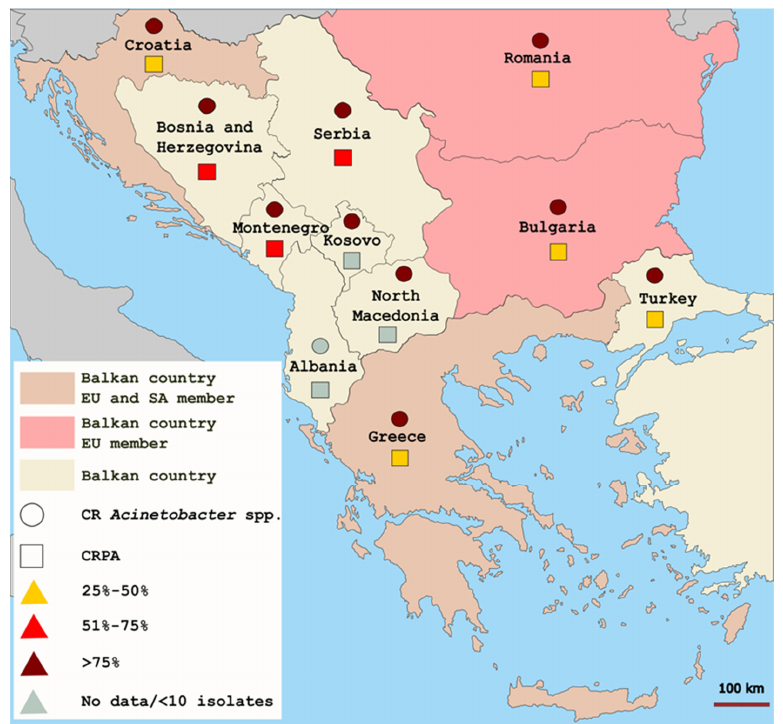
Figure 1. Geographic distribution of invasive carbapenem-resistant Acinetobacter spp. and P. aeruginosa on the Balkans according to the 2020 annual report of the ECDC [37]. CR, carbapenem-resistant; CRPA, carbapenem-resistant P. aeruginosa ; EU, European Union; SA, Schengen Area. On the other hand, the prevalence of MDR (combined resistance to carbapenems, fluoroquinolones, and aminoglycosides) Acinetobacter spp. exceeded 70%, with the high- est values reported in Serbia (95.9%) and Croatia (95.1%) and the lowest in Kosovo (71.2%) and Bulgaria (72.9%). The incidence of MDR (combined resistance to ≥ 3 antimicrobial groups, including piperacillin-tazobactam, ceftazidime, carbapenems, fluoroquinolones, and aminoglycosides) P. aeruginosa varied widely, from 11.6% (Croatia) to 61.4% (Serbia) [37]. The report lacks data for Albania. The data are presented in Figure 2.